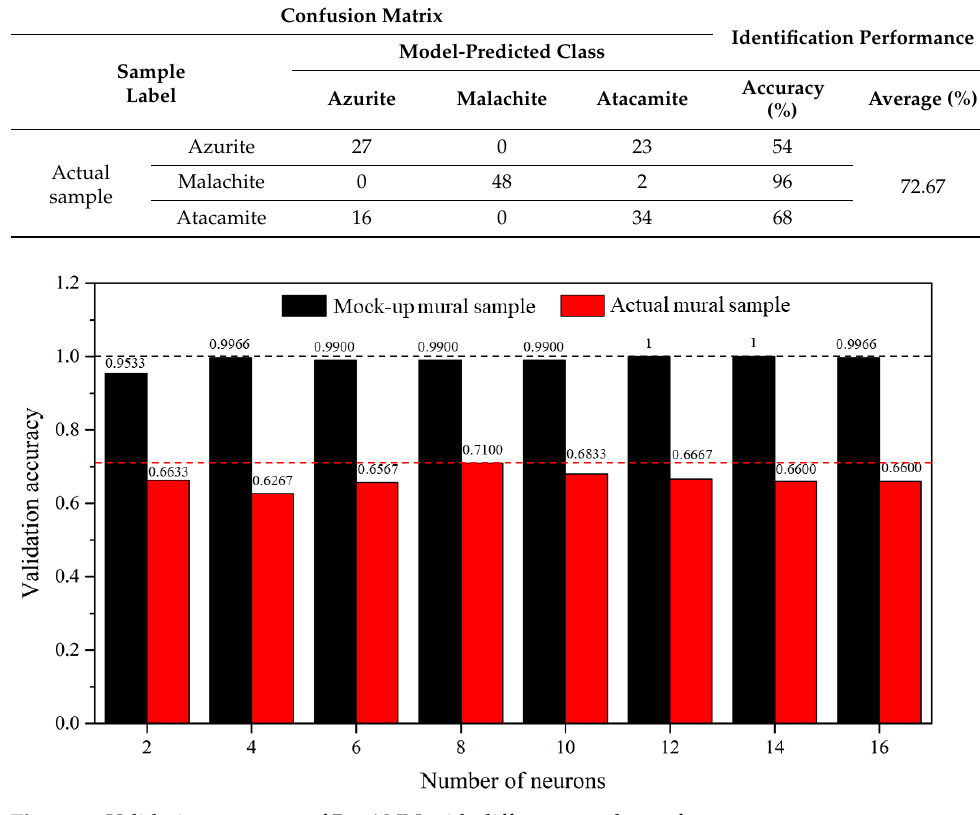
Figure 8. Validation accuracy of Bp-ANN with different numbers of neurons.